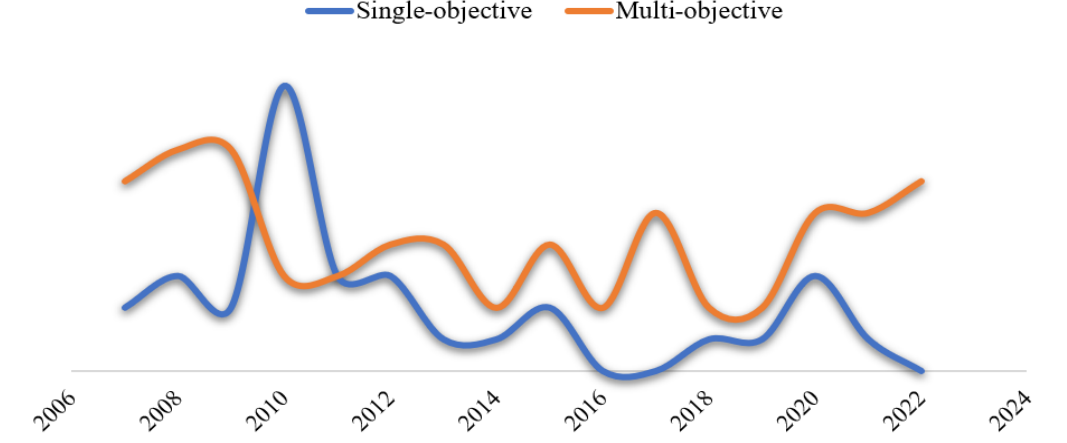
Fig. 7. Distribution of the papers on the types of objective function